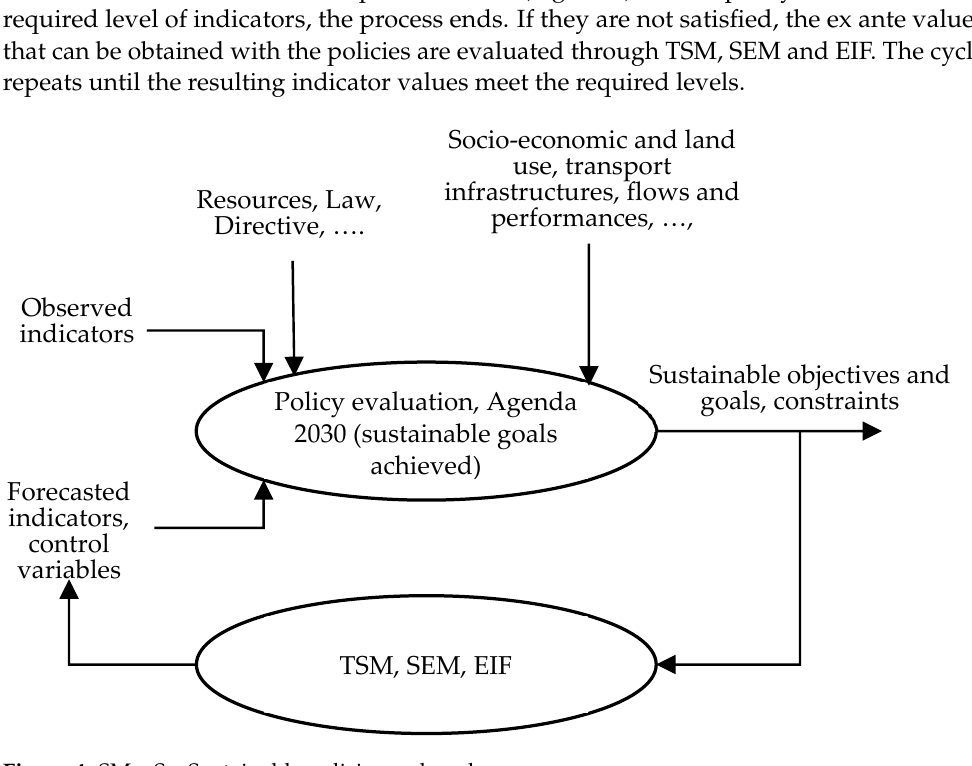
Figure 4. SMaaS—Sustainable policies and goals. These interventions have an impact on the indicators of Table 1, modifying their quantitative values, which can be evaluated ex ante through the TSM. MaaS has the possibility to indirectly affect other goals. For example, economic and social goals (Table 2) can be affected by the use of new vehicles and infrastructures.